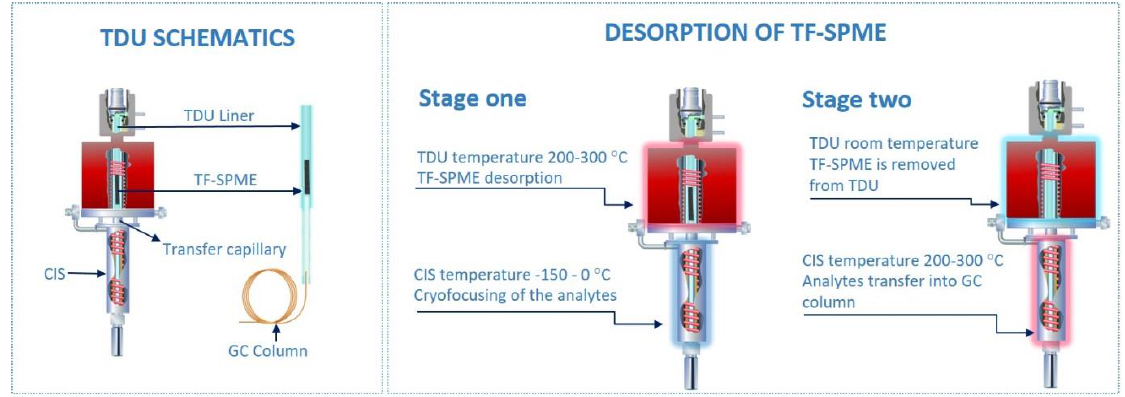
Figure 1. Two-stage thermal desorption unit for thin film solid phase microextraction (TF-SPME) (photo courtesy of GERSTEL Inc.). For the purpose of clarity, the CIS (cooled injection system) is referred to as a cryo-trap in the text. TDU, thermal desorption unit; GC, gas chromatography.